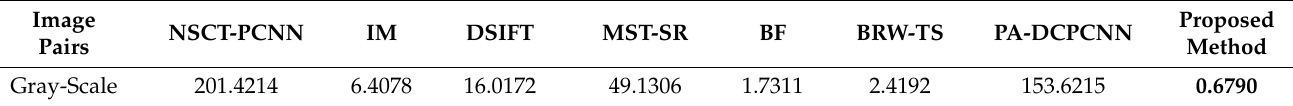
Table 15. Average running time (in seconds) of different